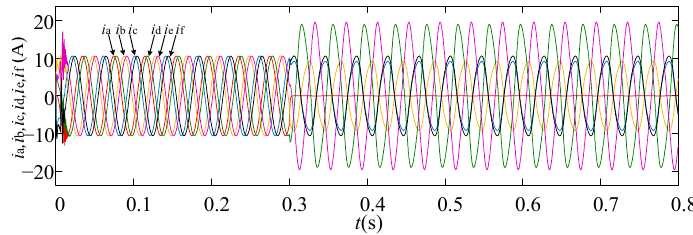
Figure 10. Fault indicators under normal operation load and disturbance. The current waveform of the open-circuit fault of phase a at 0.3 s is shown in Figure 11. The load torque is 30 N · m, and the phase failure of phase a occurs at 0.3 s. The phase a current becomes zero after 0.3 s. Among the remaining four-phase currents, phase b and phase c have the same amplitude and complementary waveforms, and the waveform amplitude and phase of phase d , e and f change to varying degrees.